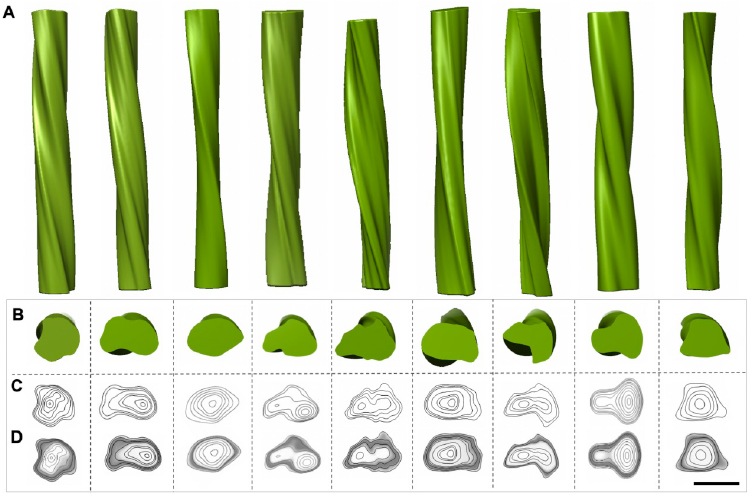
Fig 9. Gallery of independent, 3D reconstructions of one-protofilament L-type BSE fibrils. ( A ) 3D volumes of various thin, one-protofilament L-type BSE fibrils. ( B ) Cross-section views of the helical reconstructions. ( C ) Contour maps and ( D ) density maps of the reconstructed volumes. Scale bar = 10